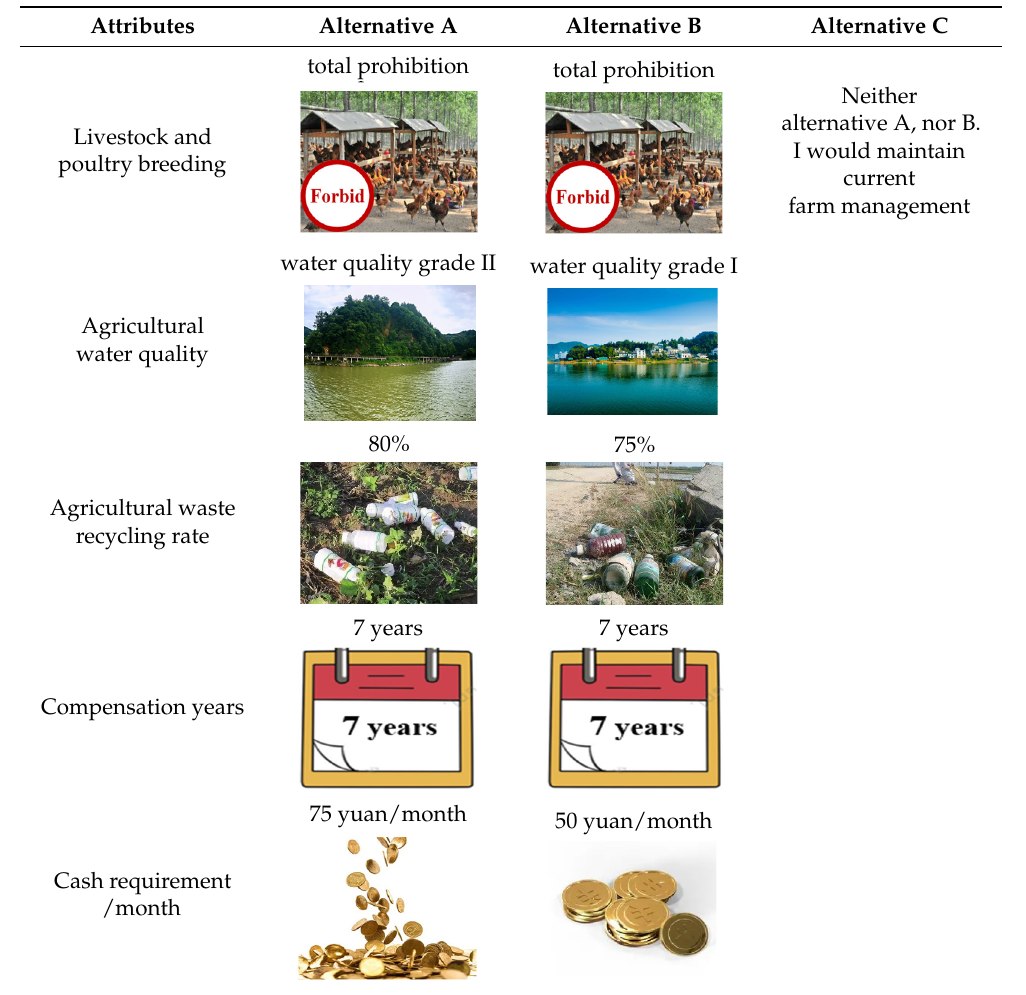
Table 2. A sample choice set.